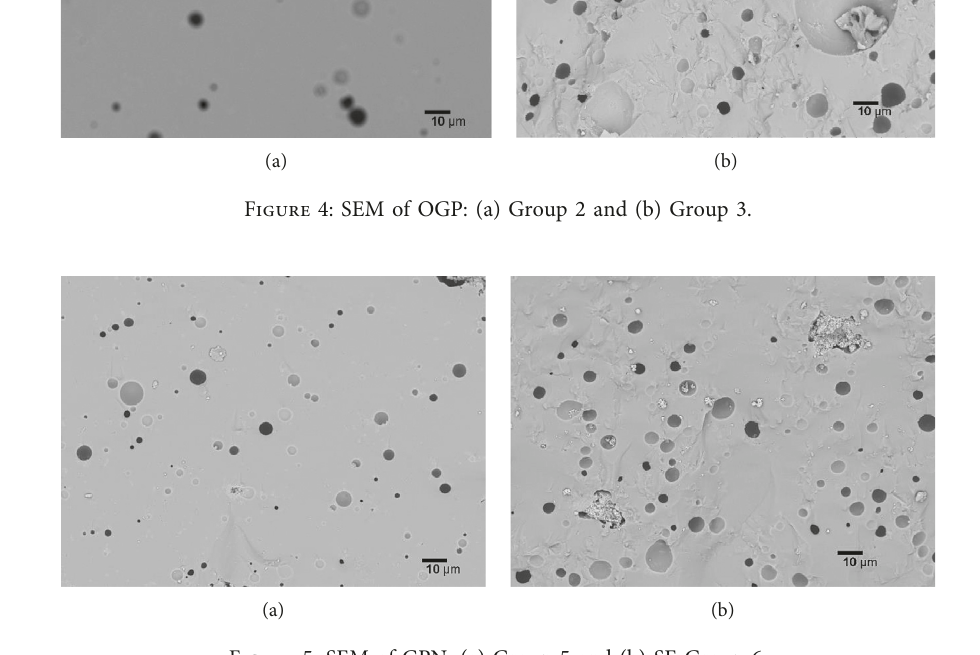
Figure 5: SEM of GPN: (a) Group 5 and (b) SE Group 6. Table 3: Flexural strength and Weibull modulus of all